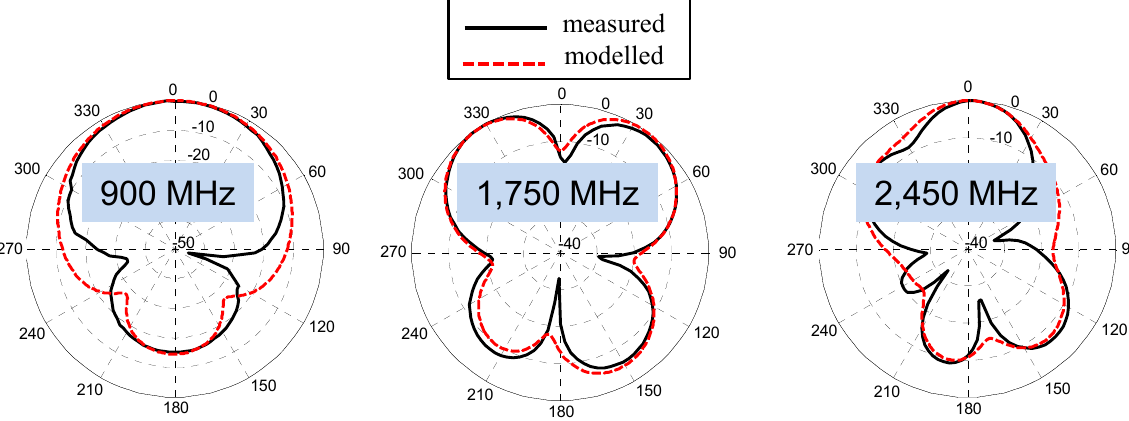
Figure 8. Measured and simulated radiation patterns of the two-port ring antenna at the three operating